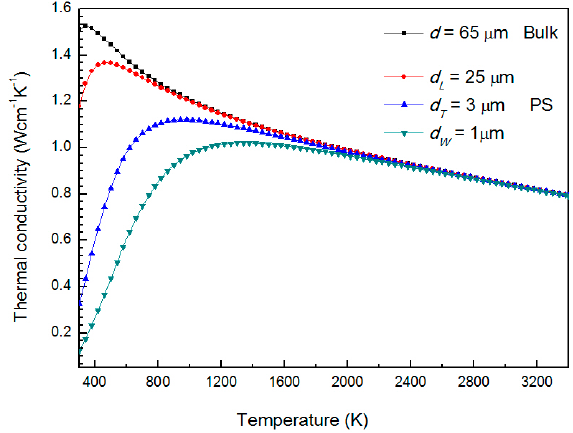
Figure 8. Thermal conductivity of W vs. temperature calculated for different grain sizes.